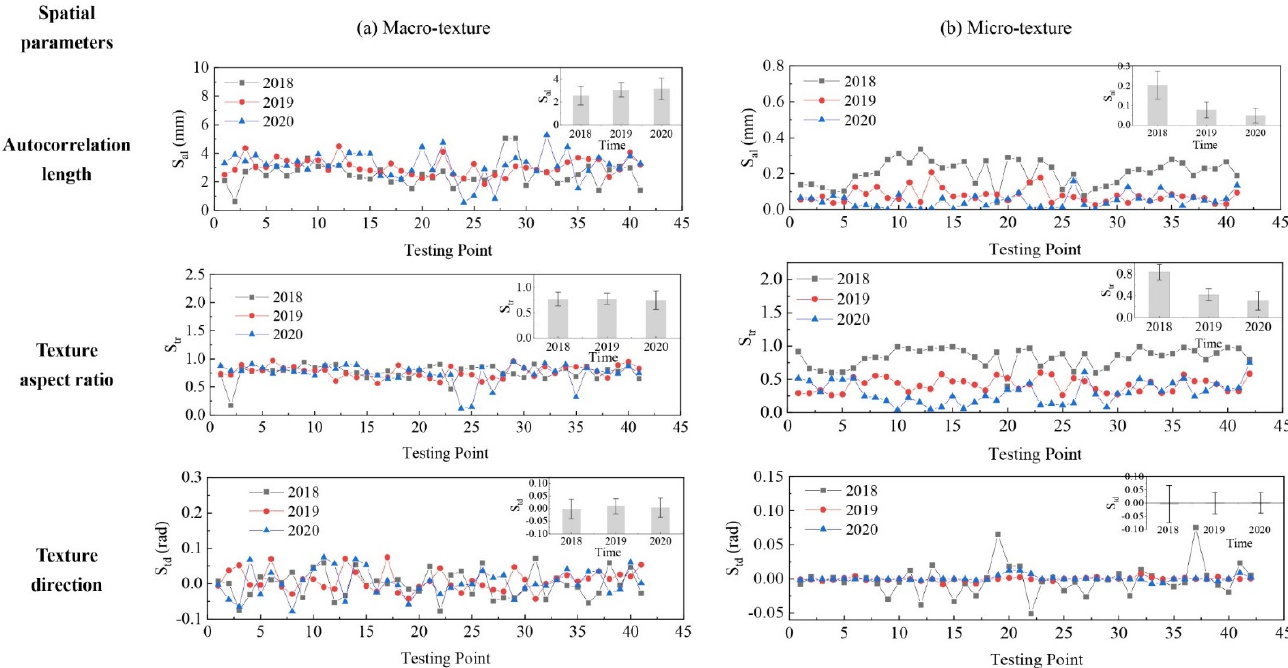
Figure 7. Pavement texture variations via spatial parameters: ( a ) Macro-texture, and ( b ) Micro-texture. For micro-texture from 2018 to 2020, (1) the S al had a descent of 62.3% from 2018 to 2019, and 36.7% from 2019 to 2020; (2) the S tr decreased year after year, indicating the texture changed from isotropic to anisotropic under traffic polishing; (3) the S td was fluc- tuating around zero, and its deviation decreased year after year. As shown in Figure 8b, the shape of ACF = 0.2 was round in 2018 and became long and thin in 2020, which corre- sponded to S tr =r min /r max decreased from 1.0 to 0.